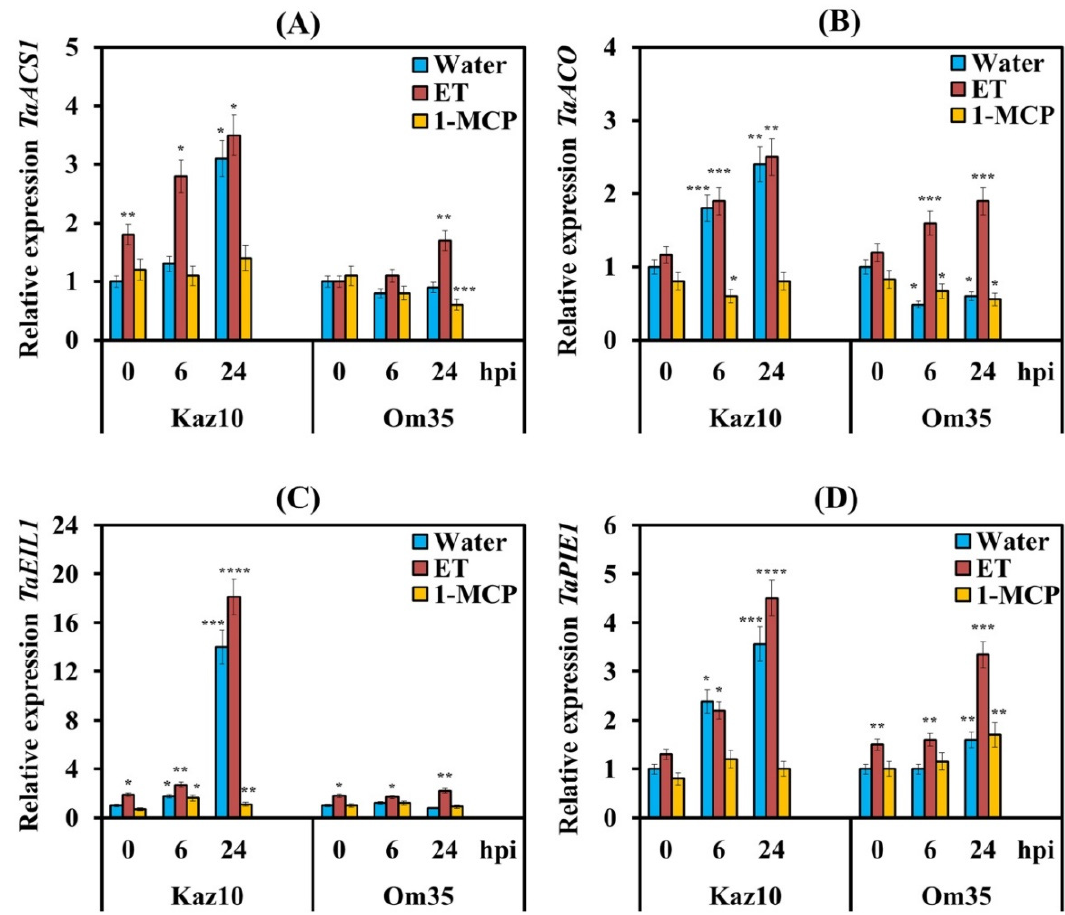
Figure 2. Pretreatment with ethephone (ET) upregulated and pretreatment with 1-MCP downregulated the relative expression of genes involved in the biosynthesis and signaling pathway of ethylene at the early stages of infection of Kaz10 and Om35 wheat cultivars infected with SnB. ( A ) The mRNA level of the TaACS1 gene. ( B ) TaACO gene. ( C ) TaEIL1 gene. ( D ) TaPIE1 gene. Expression values were normalized to the housekeeping gene TaRLI as an internal reference and expressed relative to the normalized expression levels in mock-treated control (water) plants at 0 hpi. The samples are indicated as follows: water—noninfected plants (0 hpi) or plants infected with the S. nodorum , sprayed in water; ET—noninfected plants (0 hpi) or plants infected with S. nodorum , treated with ethephone (ET); 1-MCP—uninfected plants (0 hpi) or plants infected with S. nodorum, treated with 1-methylcyclopropene (1-MCP). Figures present means ± SE (n = 6). Asterisks indicate means statistically different from the control and different number of asterisks (*, **, ***, ****) allows distinguishing of significantly different variants according to the LSD test at * p < 0.05, ** p < 0.01, *** p < 0.001, **** p < 0.0001.